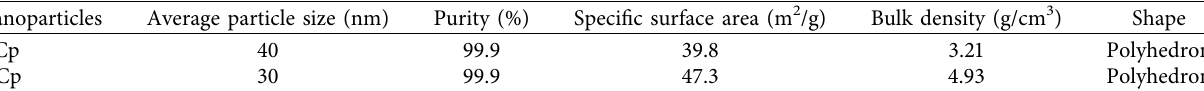
Table 2: Performance parameters of